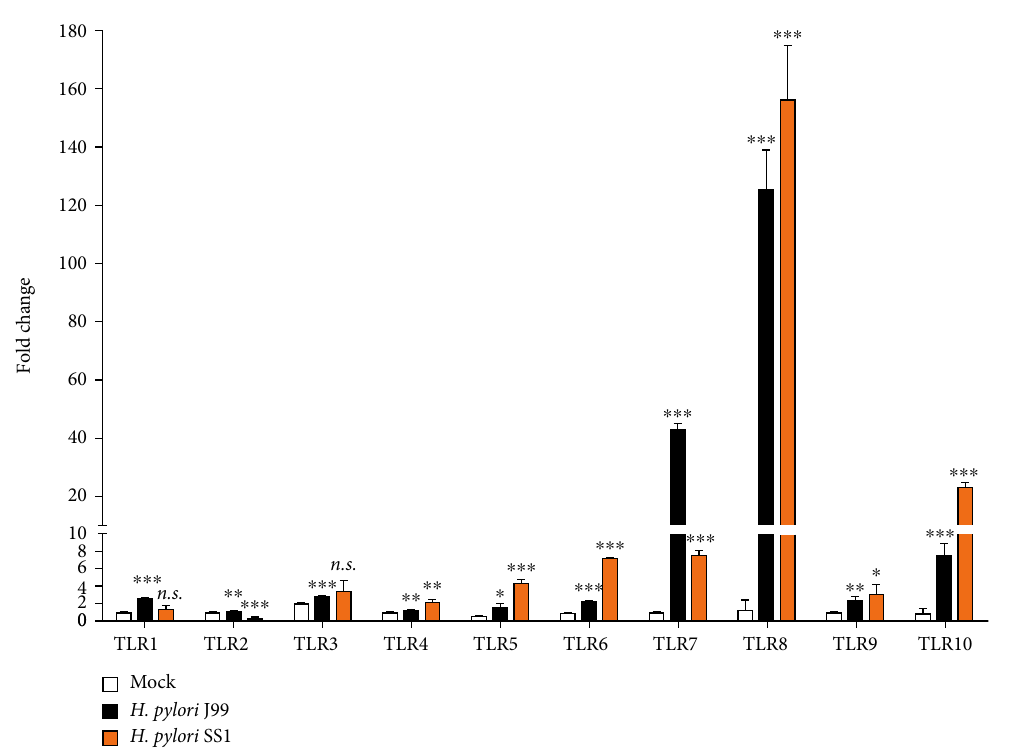
Figure 1: Upregulated expressions of TLRs in the THP-1 cells upon H. pylori infection. THP-1 cells were uninfected (mock) and infected with H. pylori J99 or SS1 strains at a MOI of 10 for 16 hours before RNA isolation and qRT-PCR analysis. Y axis shows the relative fold changes of the expression of the TLR transcripts relative to the β - actin endogenous housekeeping gene. Data is presented as mean ± SD from one experiment run in triplicate and is representative of two independent experiments. Statistical signi fi cance was analyzed using Student ’ s t -test (n.s.: not signi fi cant; ∗ P ≤ 0 : 05 ; ∗∗ P ≤ 0 : 01 ; ∗∗∗ P ≤ 0 : 001 ).